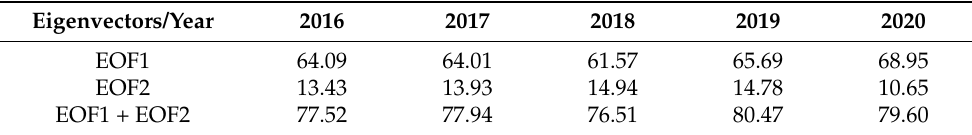
Table 1. Variance contribution of the first two eigenvectors of PM 2.5 empirical orthogonal function (EOF) decomposition in Hubei Province.